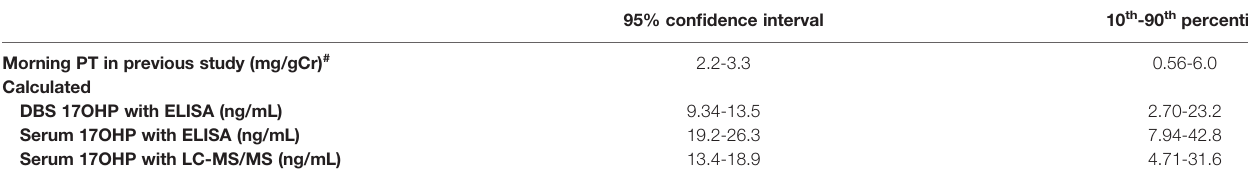
TABLE 3 | Optimal range of fi rst morning PT and 0h-17OHP based on regression